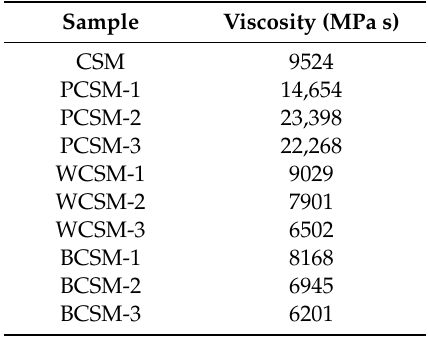
Table 3. The apparent viscosity of CSM and PCSM, WCSM, and BCSM